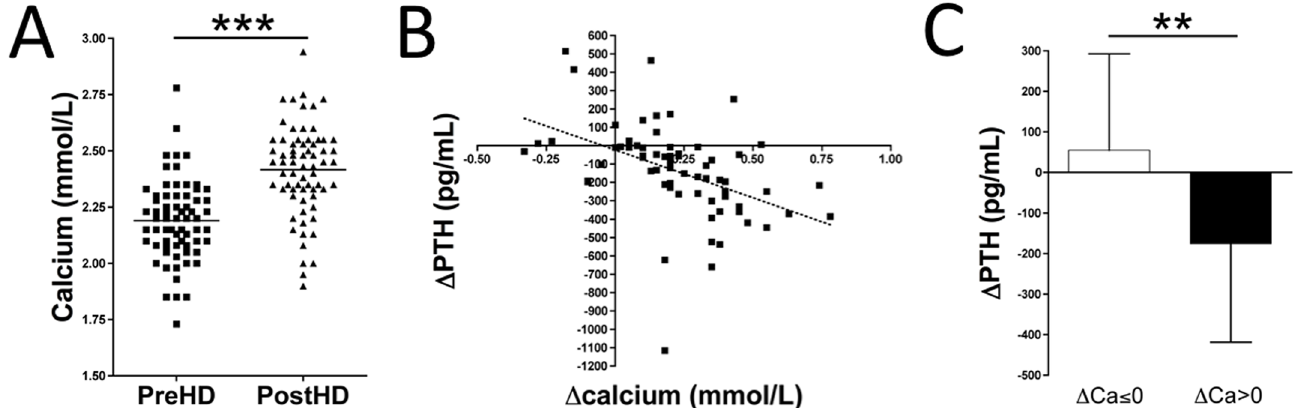
Fig 1. Calcium and PTH concentration in haemodialysis patients. ( A ) Plasma calcium concentration in pre- and post-haemodialysissamples (n = 68). The Wilcoxon matched pairs test was used for statistical analysis. ( B ) Scatter graph displayinga significant( p < 0.001) correlation between Δ Calcium( Δ Ca, the difference betweenpost- and pre-haemodialysis calcium concentration) and Δ PTH (the difference betweenpost- and pre- haemodialysis PTH concentration). ( C ) Δ PTH based on Δ Calcium( Δ Ca (cid:20) 0 or Δ Ca > 0 mmol/L). The Mann-Whitney test was used for statistical analysis. ** p < 0.01; *** p < 0.001 . PreHD ,pre-haemodialysis; PostHD , post-haemodialysis.